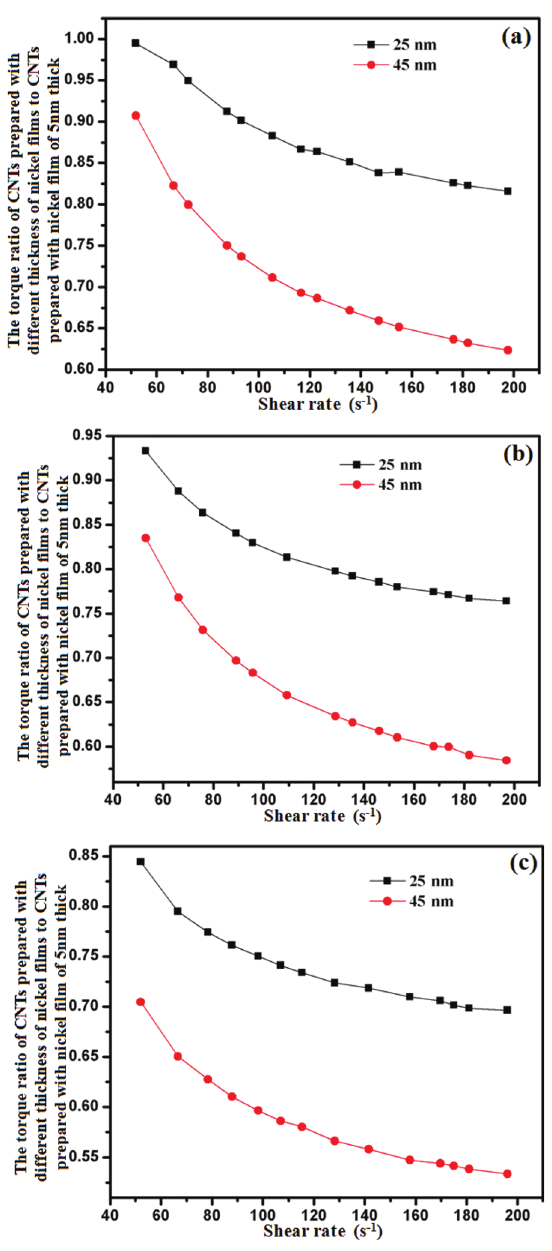
Figure 9: The variation of the torque ratio of CNTs prepared with different thickness of nickel films to CNTs prepared with nickel film of 5 nm thick (a) D = 500 μ m, (b) D = 600 μ m, (c) D = 700 μ